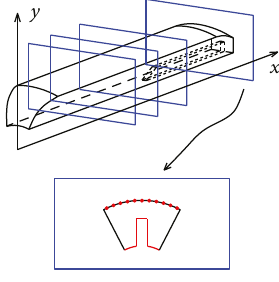
Figure 2: Discretizing and